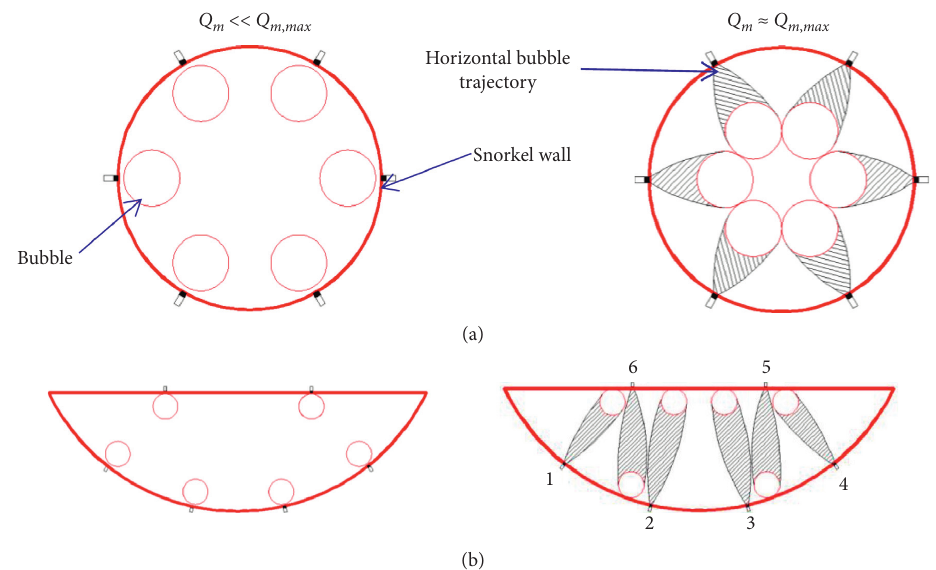
Figure 5: Illustration of bubble dispersion behavior in up-leg observed from the bath bottom. RH with (a) circular snorkels and (b) arched